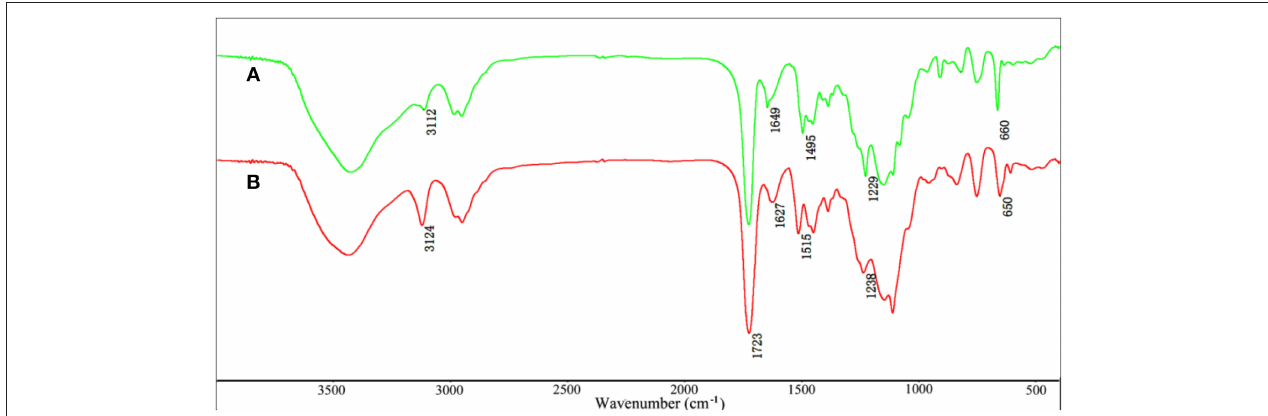
FIGURE 9 | FTIR spectra of KF@VIM/EGDMA before (A) and after (B) Hg(II) adsorption.